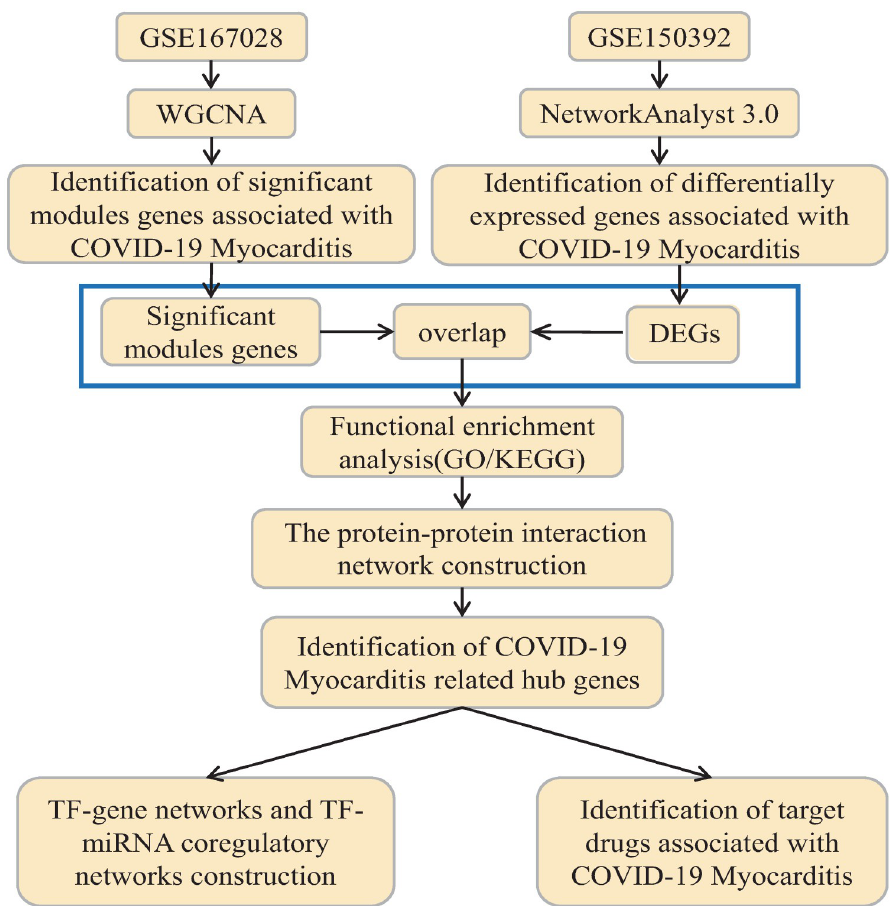
Fig 1. Workflow chart of this study. WGCNA, weighted gene correlation network analysis; DEGs, differentially expressed genes; GO, Gene Ontology; KEGG, Kyoto Encyclopedia of Genes and Genomes; TF, Transcription factor; miRNA, microRibonucleic